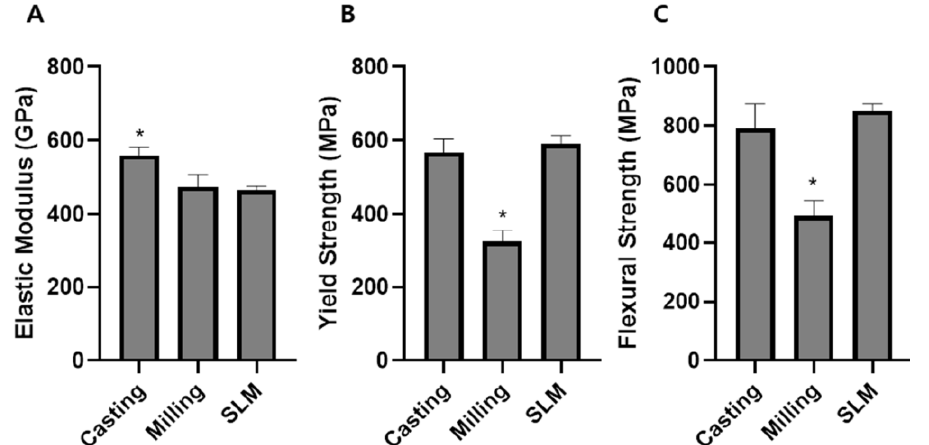
Figure 5. Mechanical properties of the casting, milling, and selective laser melting (SLM) groups: ( A ) elastic modulus, ( B ) yield strength, and ( C ) flexural strength. Asterisks (*) denote results statistically significantly di ff erent from those of the other groups ( p <